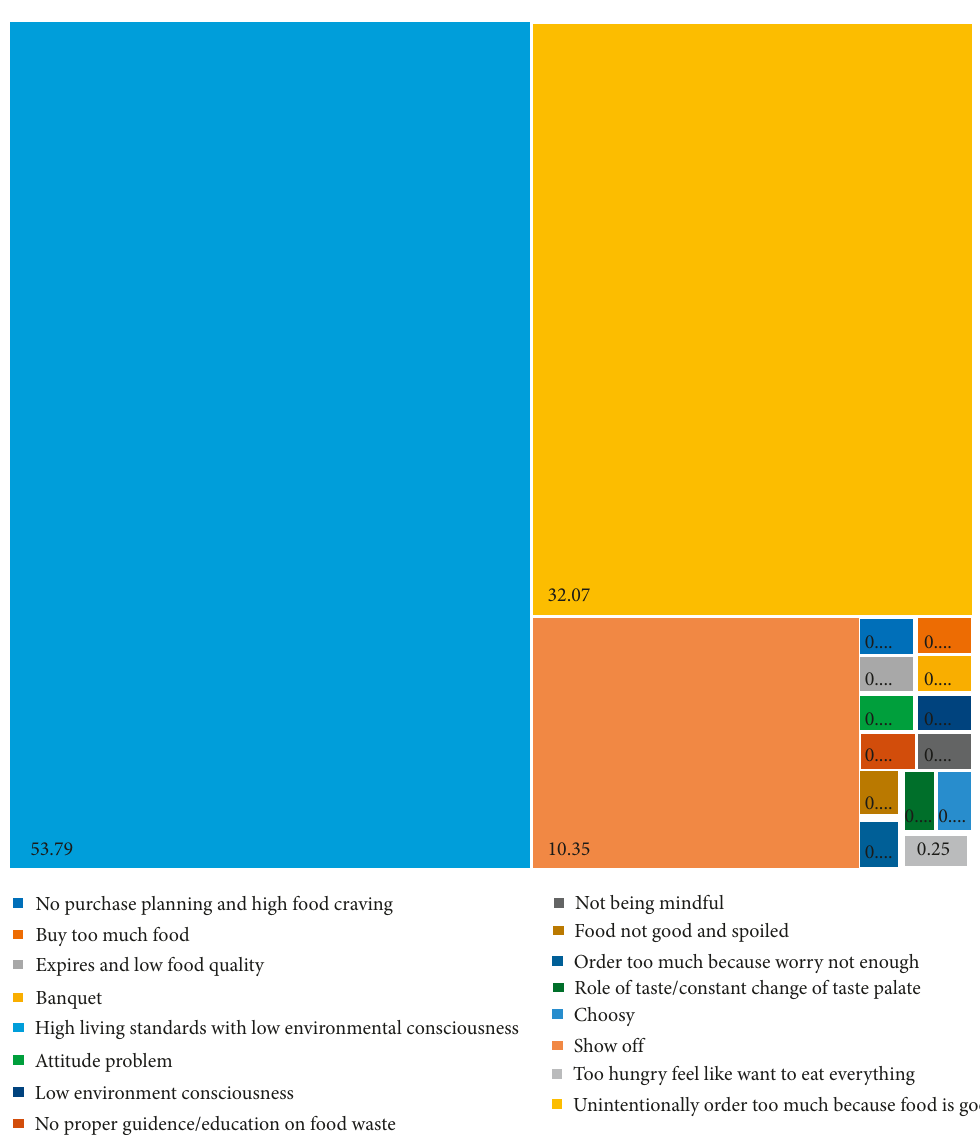
Figure 7: Current food waste reasons believed by Malaysians.